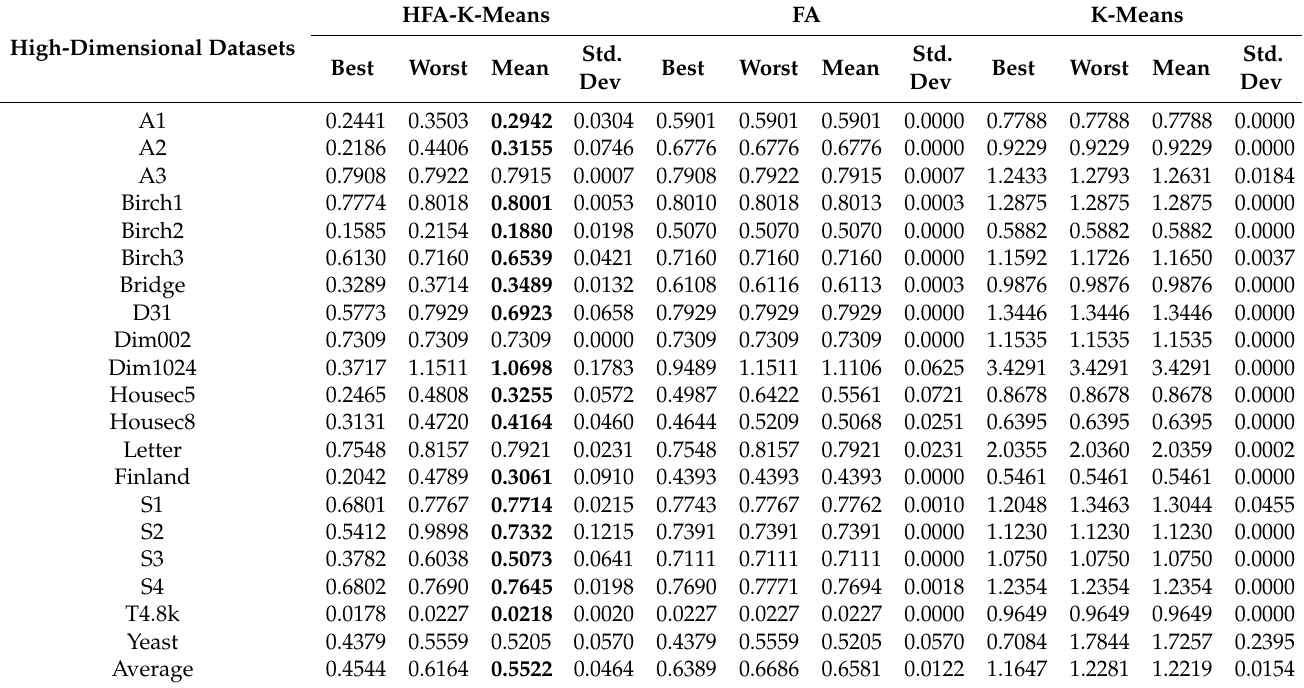
Table 6. Comparison of HFA-K-means with FA and K-means over 20 independent program execu- tions.